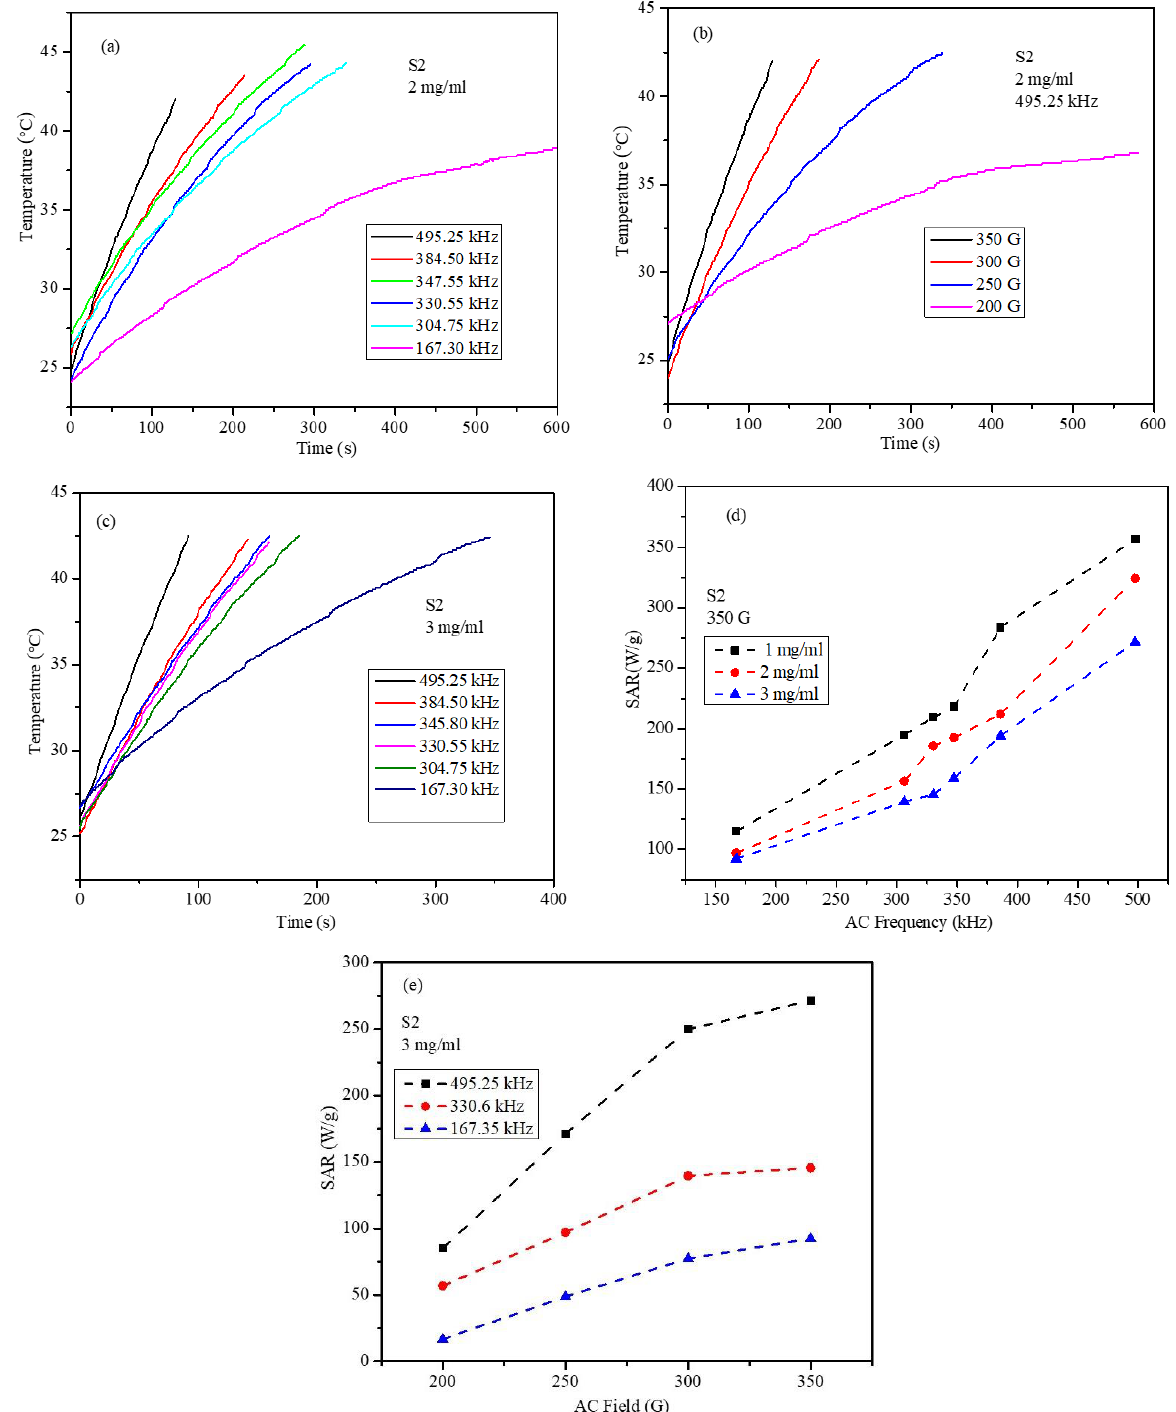
Figure 11. Heating profiles of the S2 core-shell nanoparticles; ( a ) frequency-dependent heating profiles of the S2 (2 mg/mL) nanoparticles under 350 G, ( b ) field-dependent heating profiles of the S2 (2 mg/mL) nanoparticles at a frequency of 495.25 kHz, ( c ) frequency-dependent heating profiles of the S2 (3 mg/mL) nanoparticles under 350 G, ( d ) concentration vs. frequency-dependent SAR under a field amplitude of 350 G, and ( e ) field-dependent SAR for the 3 mg/mL concentration at frequencies of 495.25, 330.6, and 167.35 kHz.